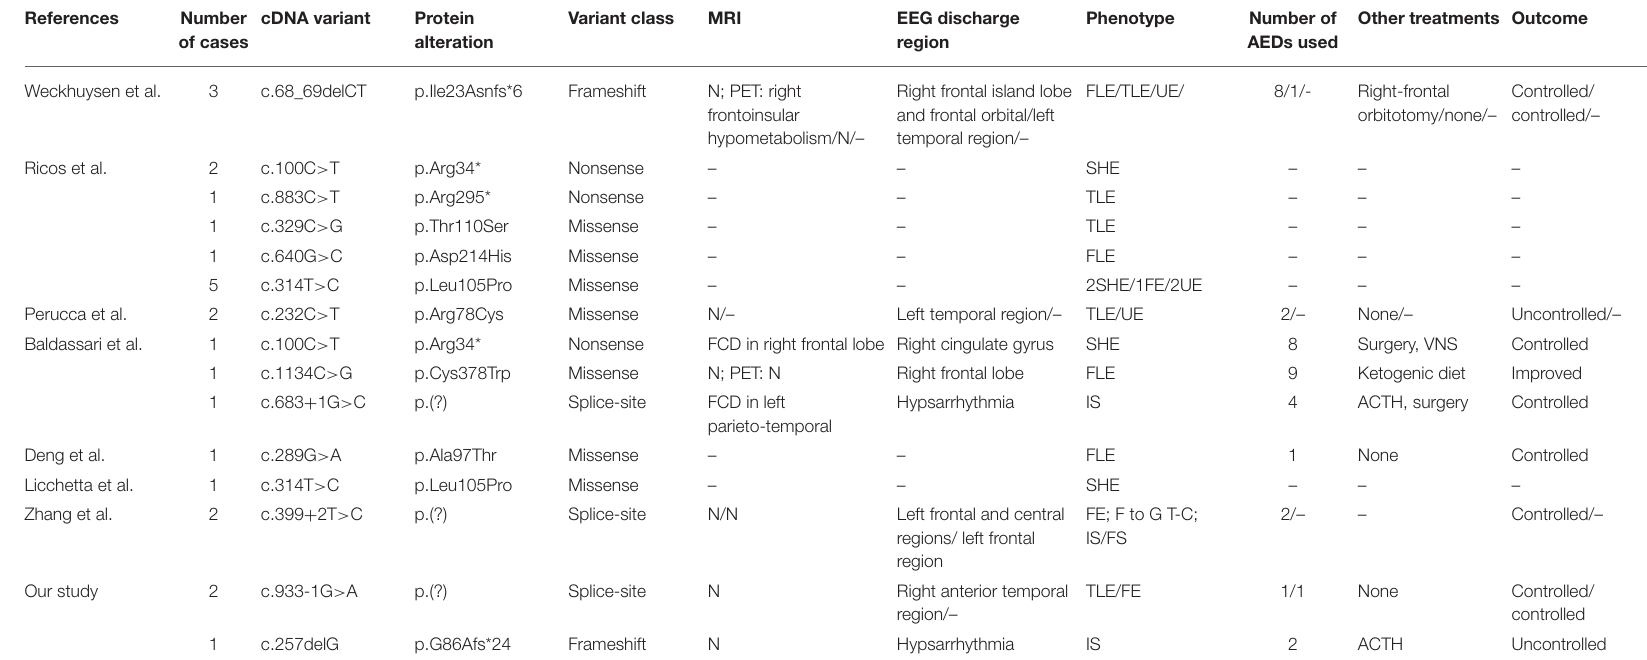
TABLE 1 | Genotypic and phenotypic characteristics of NPRL2 -related epilepsy from previous literature identified to the